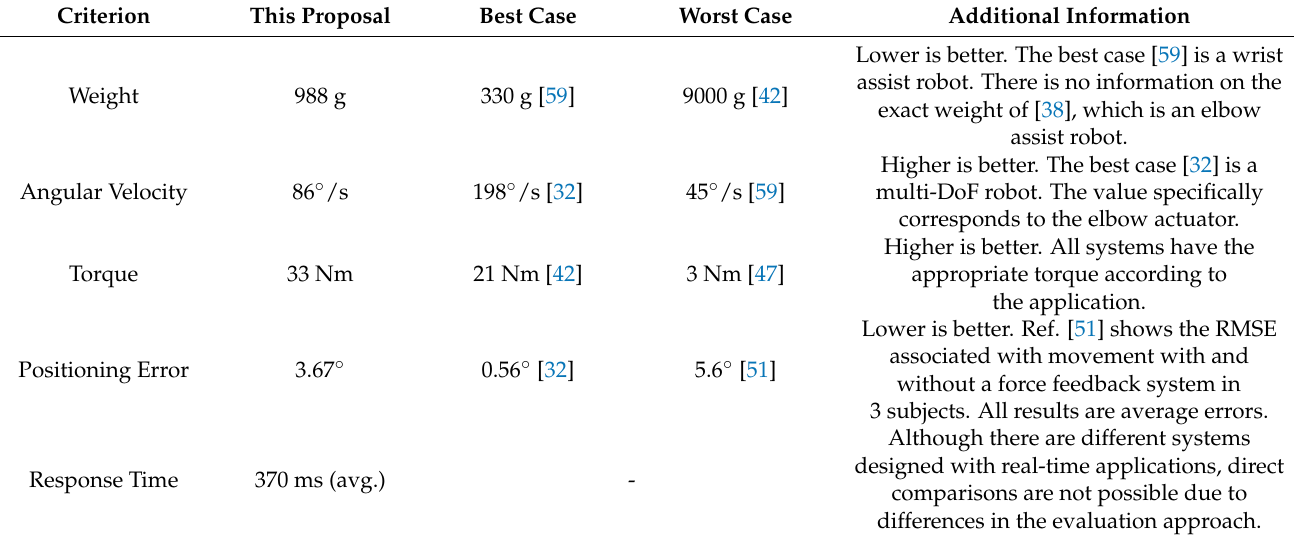
Table 5. Summary of the results obtained in comparison with previously reviewed